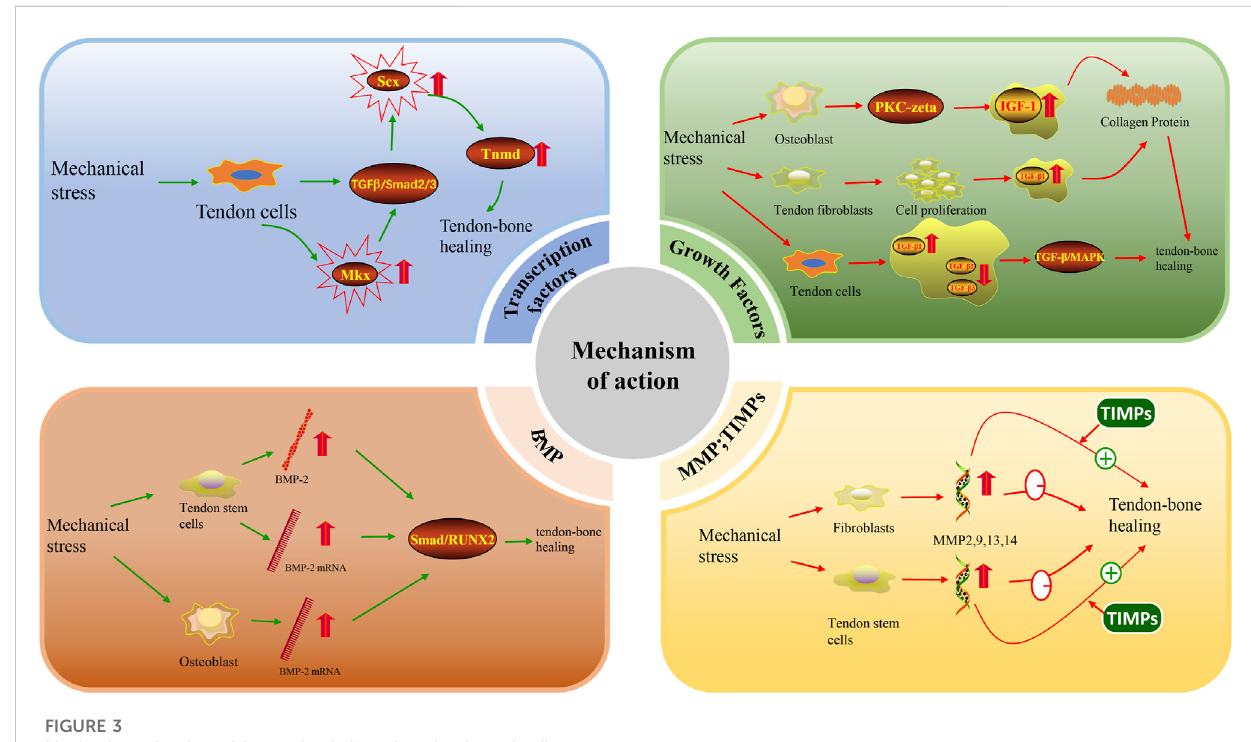
FIGURE 3 Mechanism of action of force stimulation of tendon bone